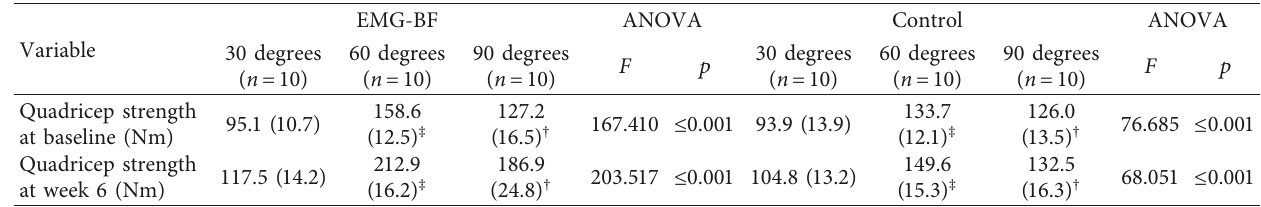
Table 2: Summary of the results of one-way analyses of